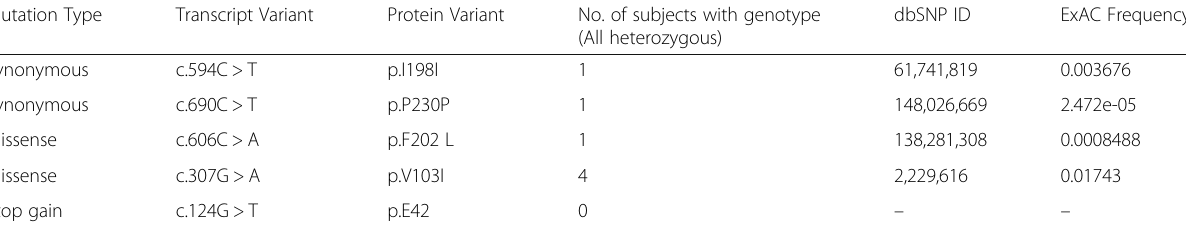
Table 1 MC4R variants identified in 120 ethnically matched controls, excluding sequenced members of the studied kindred